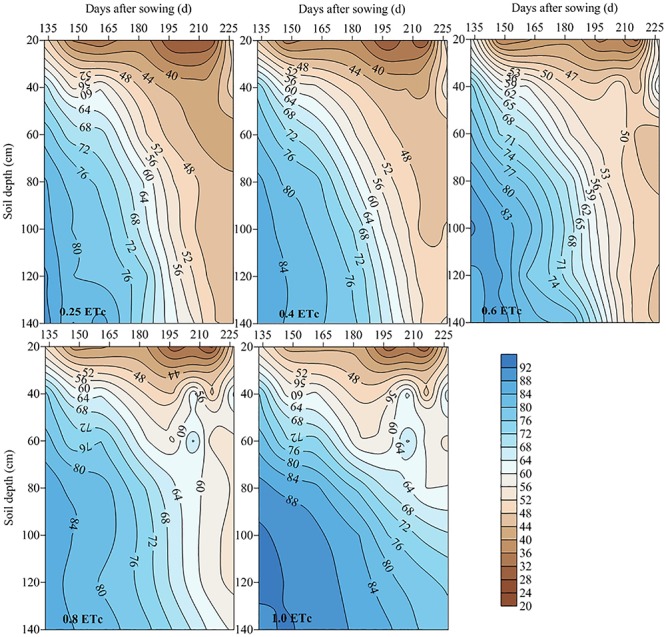
Temporal and spatial distribution of relative soil water content under different drip irrigation treatments (2016–2017). The 0.25, 0.4, 0.6, 0.8, and 1.0 ETc represents 25, 40, 60, 80, and 100% crop evapotranspiration, respectively.